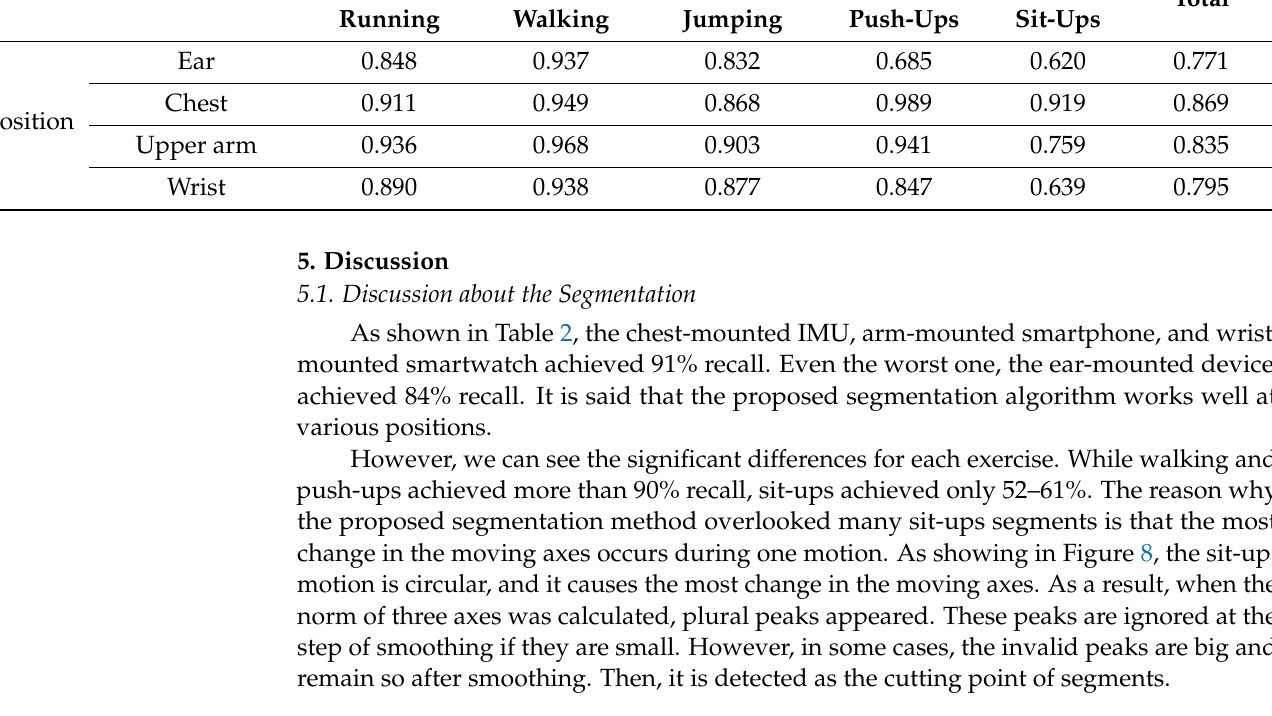
Table 5. Leave-other-subjects-out cross-validation accuracy of conventional machine learning methods (linear SVM model). Each Exercise Total Running Walking Jumping Push-Ups Sit-Ups